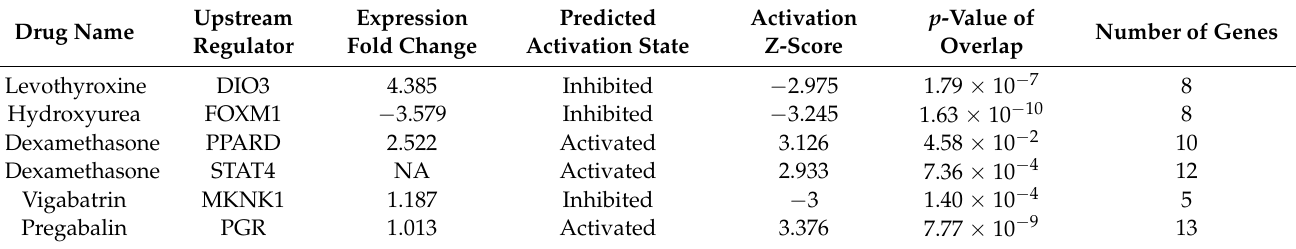
Table 1. Summary of six upstream regulators identified in the Neuron Screen